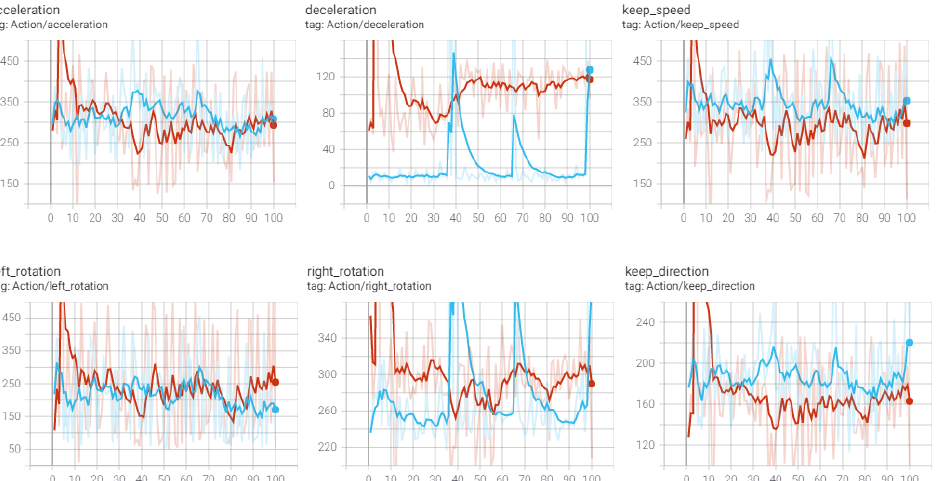
Figure 13. Actions of the autonomous ship. The autonomous ship is controlled by [acceleration/deceleration] and [steering]. The random and ILFAS RL are shown in red and green, respectively. The graph, keeping direction without controlling the speed, shows the stability of the autonomous ship. The graph for the ILFAS also shows the decrease in the stability of control in the environment that is not learned.